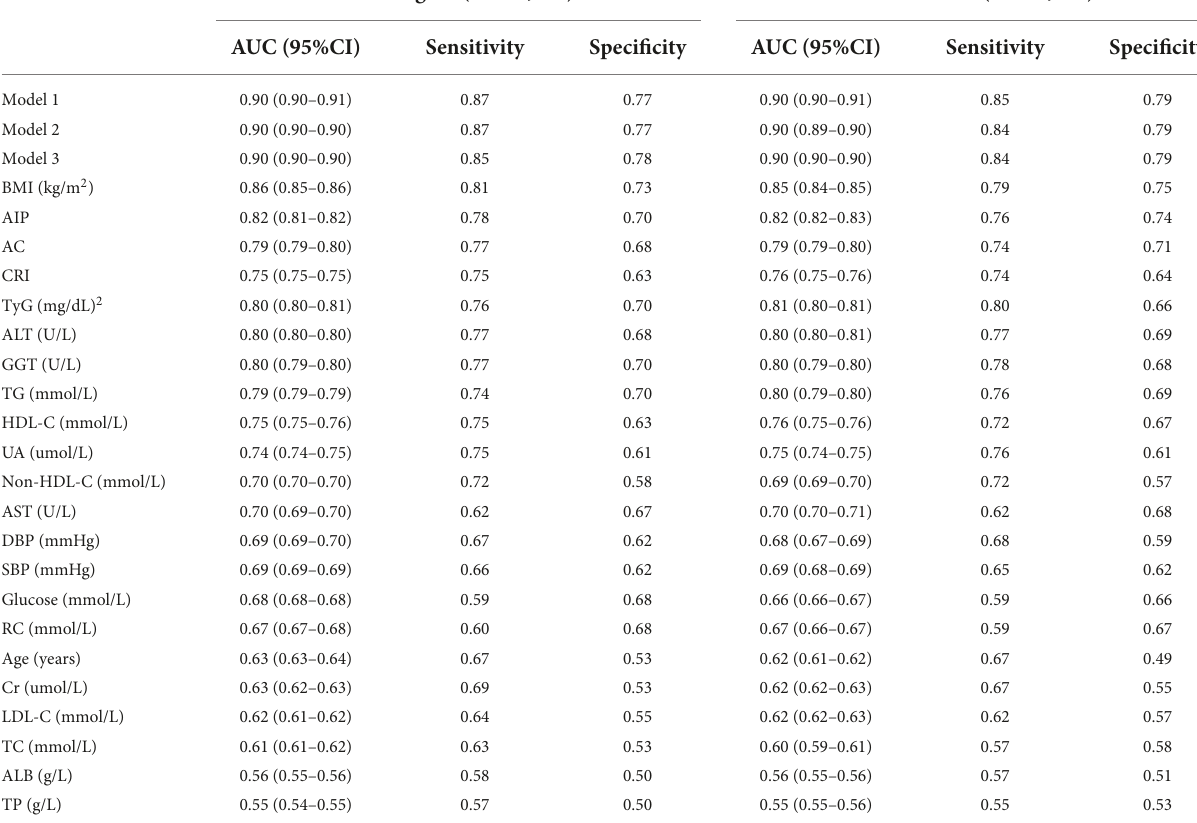
TABLE 4 ROC analyses of metabolic parameters and combined models for